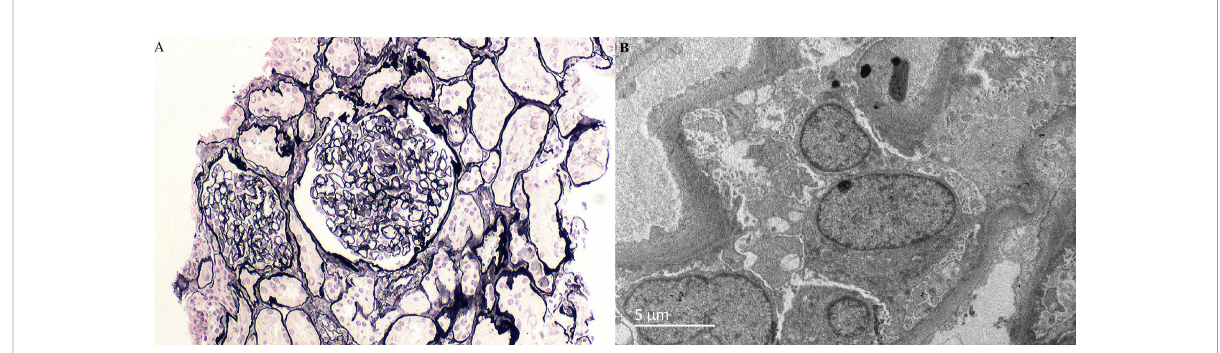
FIGURE 2 Light microscopy and electron microscopy images of histological changes in the renal biopsy. (A) Periodic acid – silver methenamine (PASM) (× 400). Mild glomerular lesions, no segmental sclerosis, tubular atrophy, and interstitial fi brosis. (B) Electron micrograph (× 6000) showed a normal glomerular basement membrane, no immune deposits, and widespread fusion of the epithelial cell foot